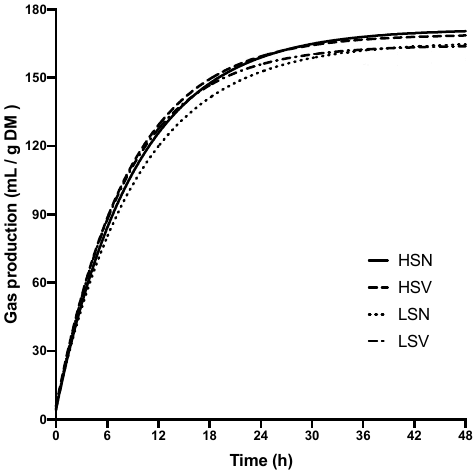
Figure 3. The effect of M-CMS supplementation with different corn silage levels on gas production (Experiment 2). HSN: high-level (accounts for 60% of forage) corn silage diet; HSV: high-level corn silage diet + M-CMS; LSN: low-level (accounts for 30% of forage) corn silage diet; LSV: low-level corn silage diet + M-CMS; M-CMS: molasses + condensed molasses fermentation solubles (1:1 mixture). Table 6. The effect of M-CMS supplementation with different corn silage levels on gas kinetic parameters (Experiment 2). Treatment 1 Effect ( p -Value)